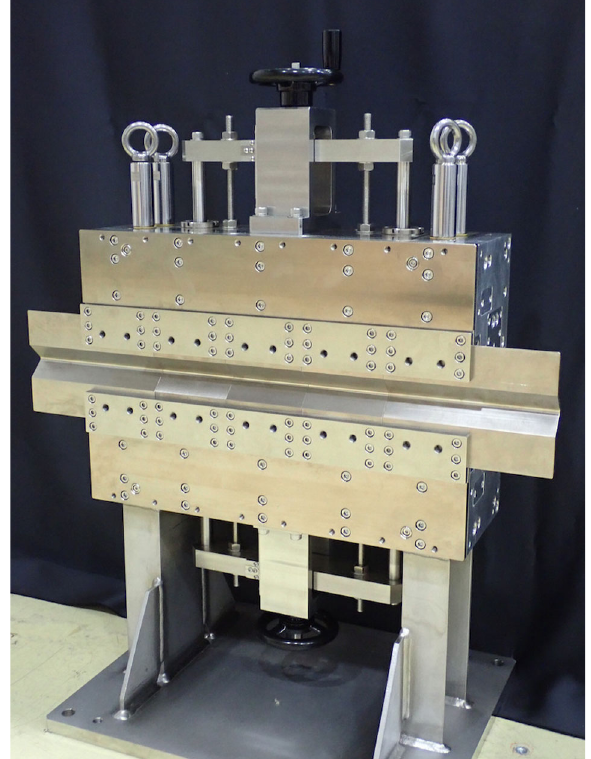
FIG. 7. Fabricated PM-based septum magnet. Septum plates are extended by 80 mm to the shield fringe field in the beam